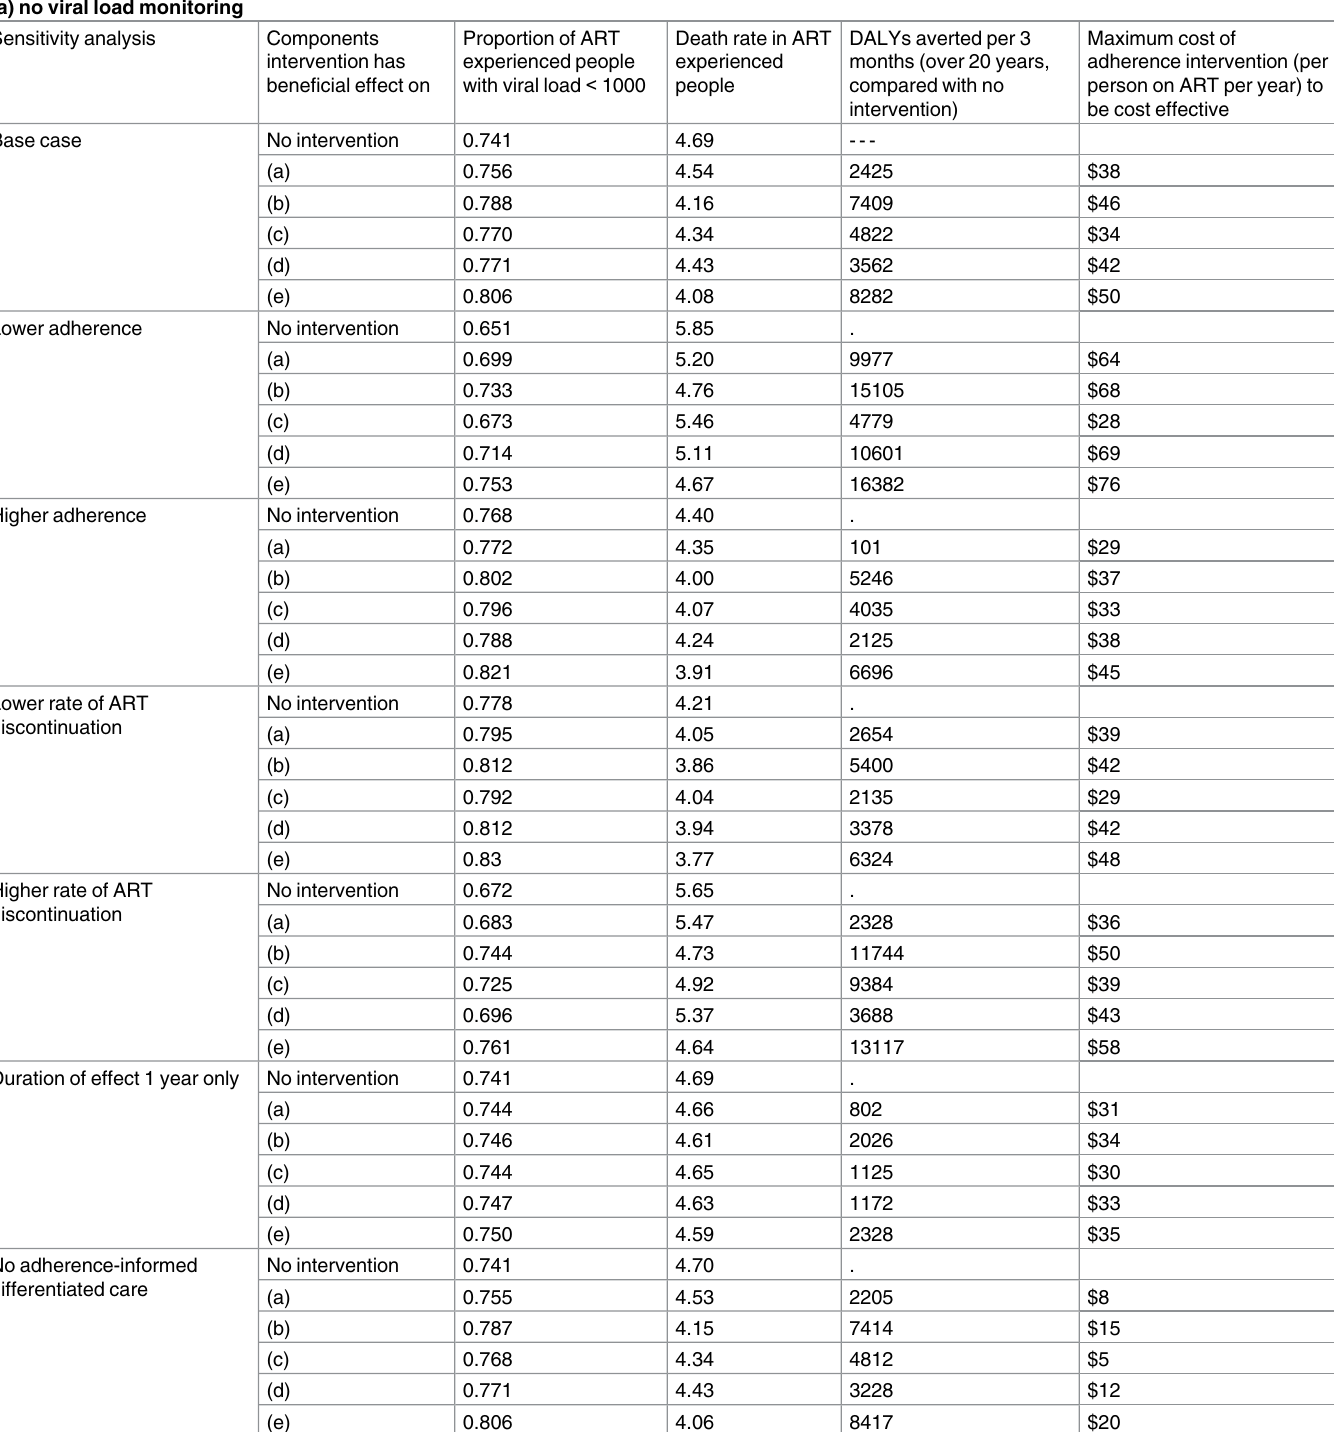
Table 3. Sensitivity analyses(a) in context of no viral load monitoring (b) in context of viral load monitoring. All in context of an intervention with a durableeffect and the intervention being effective in 50% of people. (a) no viral load